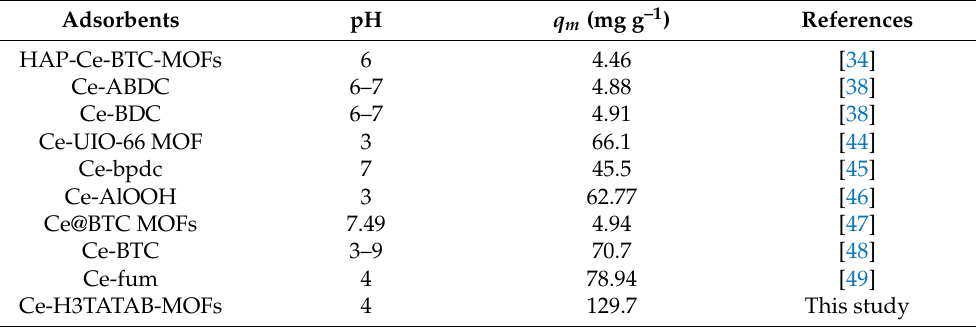
Table 6. Comparison of fluoride sorption capacity with previously reported adsorbents.